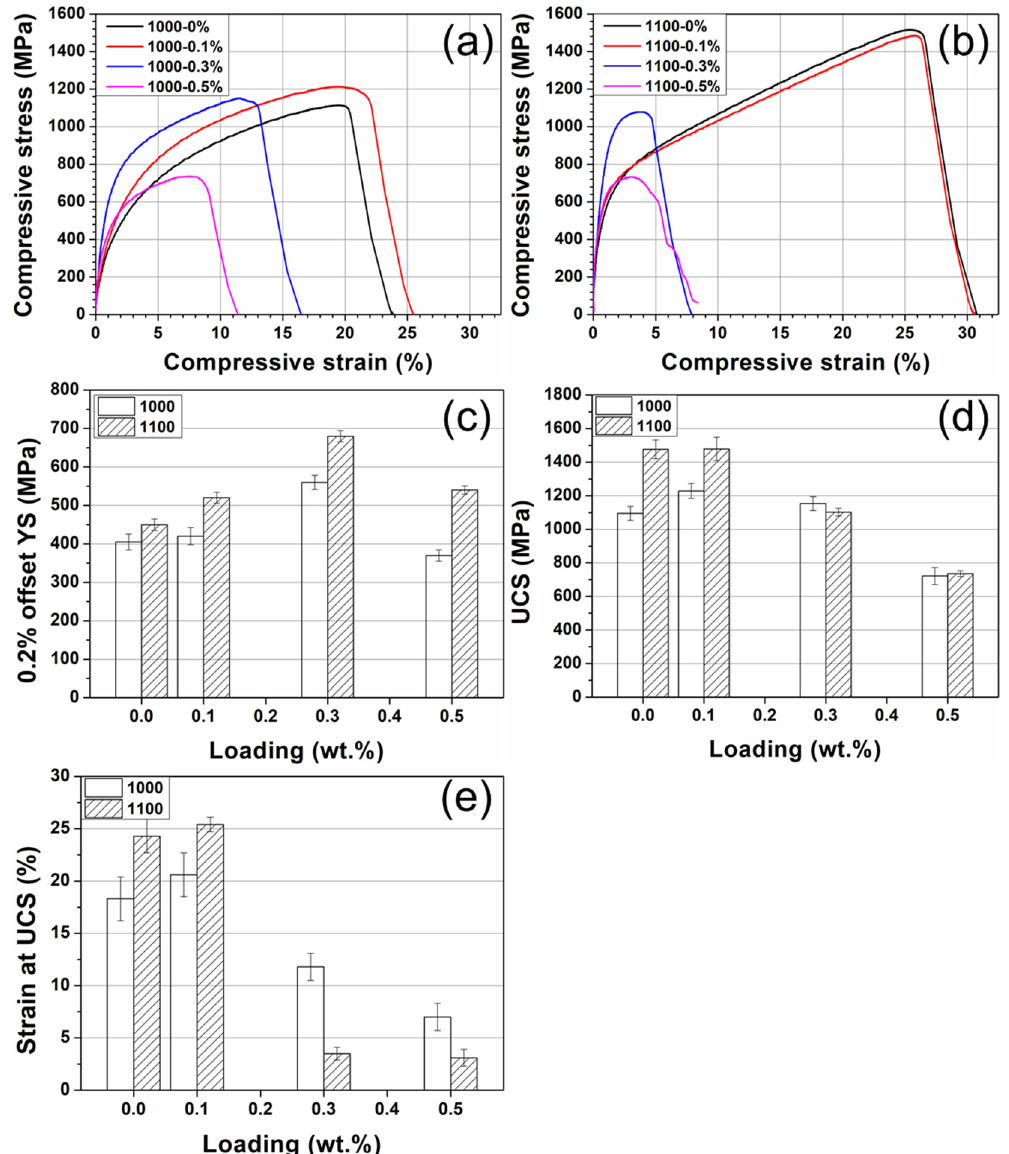
Figure 8. ( a , b ) Compressive stress–strain curves for samples with loadings of 0, 0.1, 0.3, and 0.5 wt.% GO at 1000 and 1100 °C, respectively. Each curve in the plot is the most representative one for each sample. The pillars tested had a diameter of 1.5 mm and height of 4.5 mm and 8 specimens were tested for each composition. ( c ) 0.2 % offset yield strength, ( d ) Ultimate compressive stress (UCS) and ( e ) strain at UCS for Cu-W matrix composites with different loadings of GO produced by SPS at 1000 and 1100 °C.